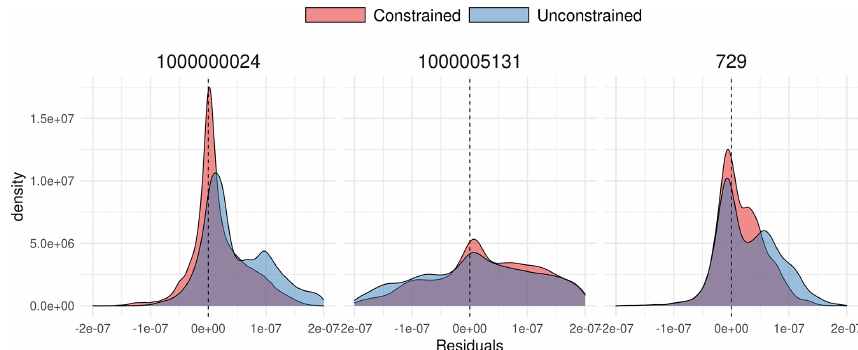
Figure A2. Residual density of NEE simulation by the SIPNET model for sites presented in Fig. 6.